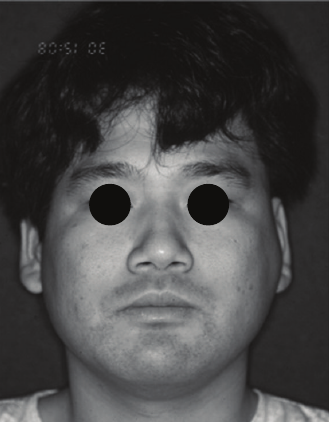
Figure 1: Left side preauricular swelling on presentation.